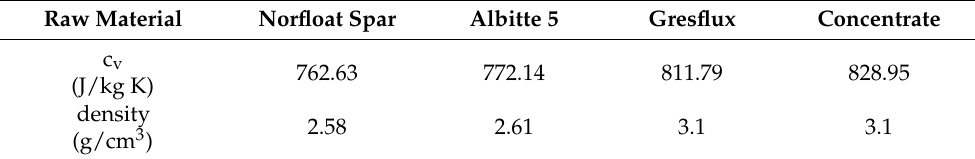
Table 4. Calculated specific heat and density of raw materials.